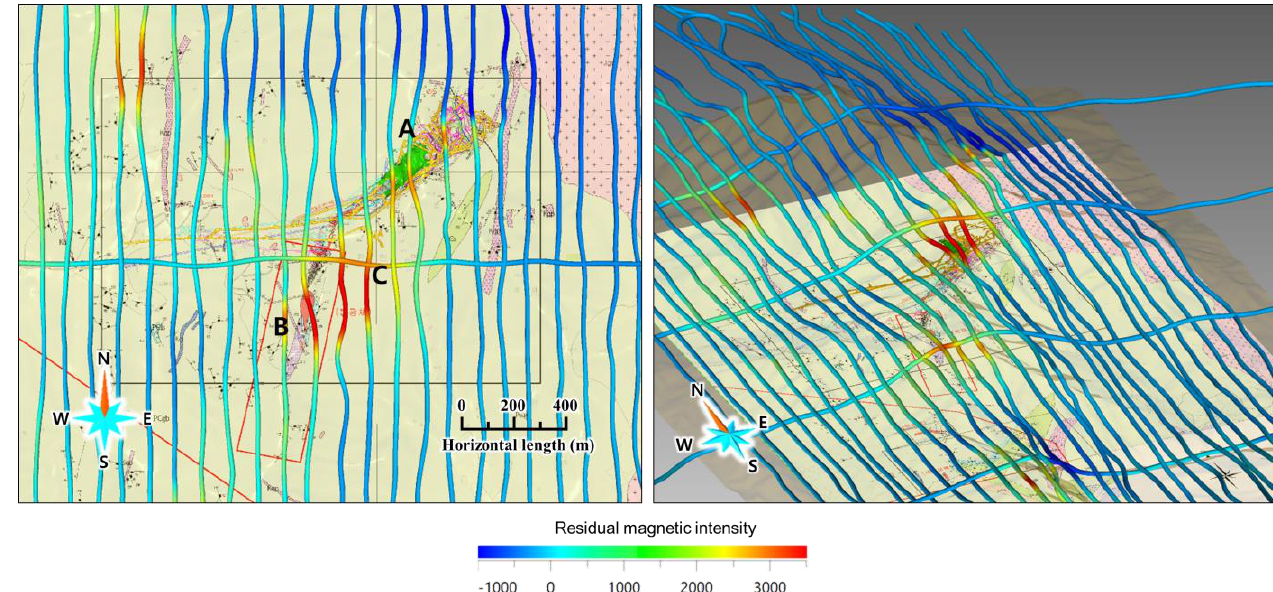
Figure 3. Aeromagnetic survey results using a helicopter in 2019.